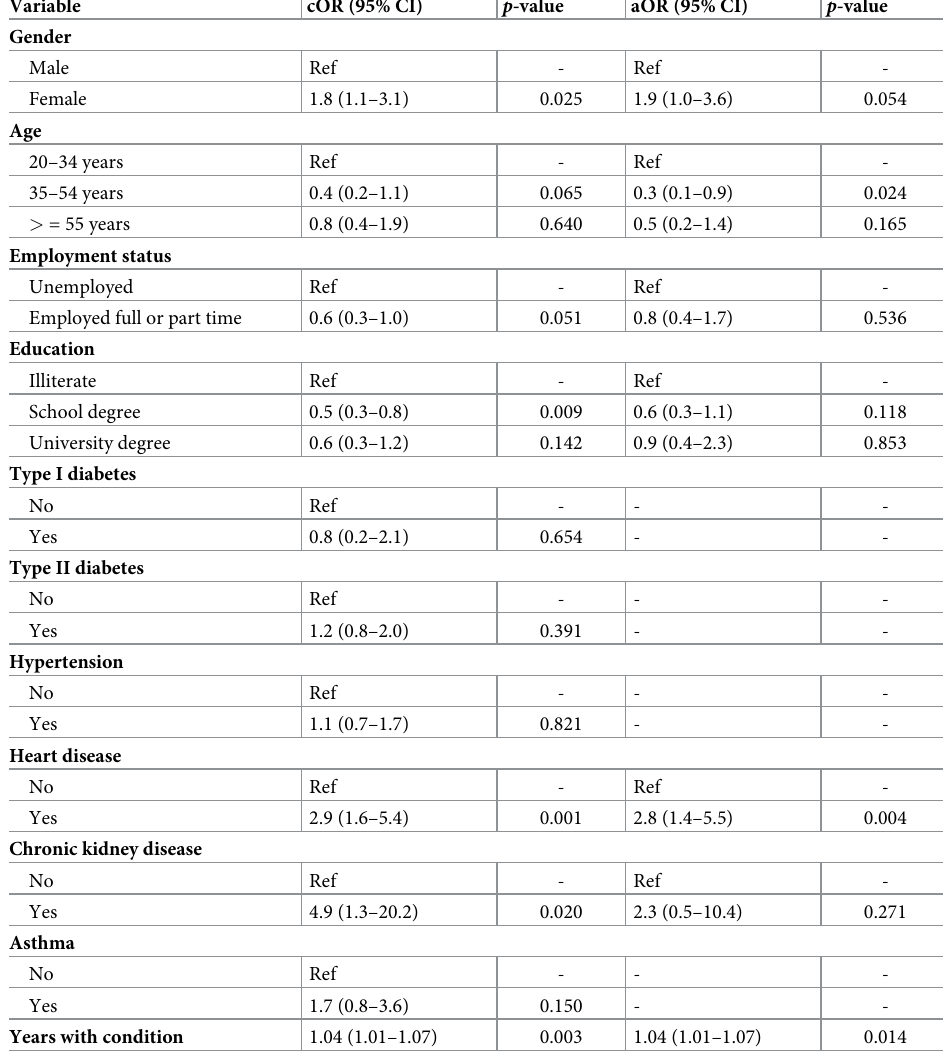
Table 3. Simple and multiple logistic regression analysis of factors affecting depression in chronic disease patients in the UAE (N = 417).